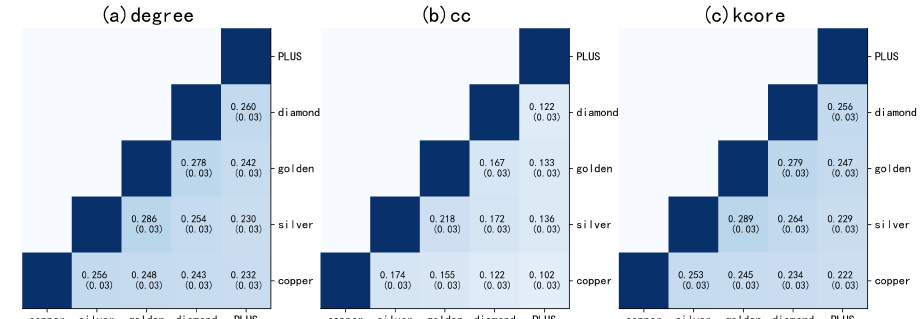
Figure 9. Similarity in expression habits across user levels. The x -axis and y -axis represent the five user levels, and the numbers in the patches refer to the average similarity with the standard deviation in brackets behind it. Patches in the grid refer to the similarity between two user levels, with darker colors indicating greater similarity. The repeating frequency was set as 1000 and the size as